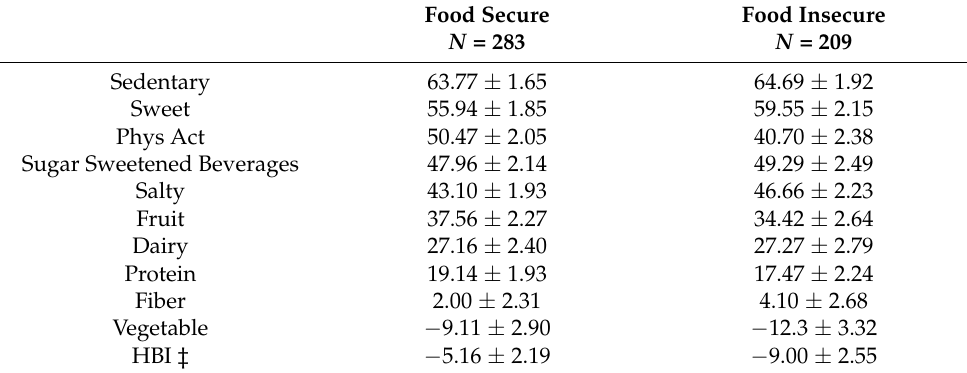
Table 3. PALS food and activity groups and Healthy Behavior Index (HBI) scores (and its diet and physical activity groups) in middle school students (School A and School B) by self-reported food security versus food insecurity †. Food Secure Food N = 283